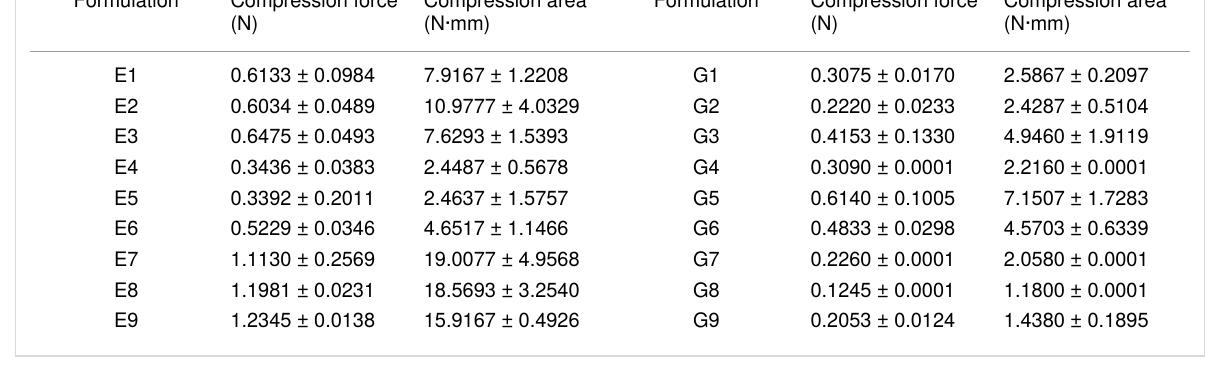
Table 3: Compression force and compression area of MNs containing EE or GE on a hard glass surface. Each analysis was performed, at least, in triplicate. Formulation